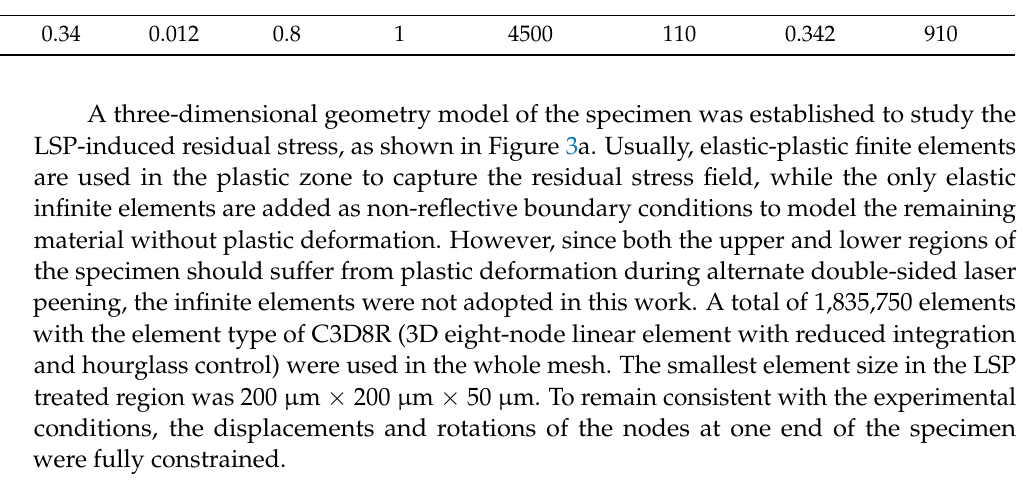
Table 1. Johnson – Cook parameters and mechanical properties of Ti-6Al-4V titanium alloy.